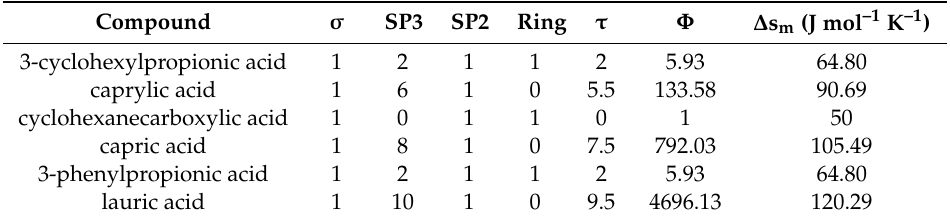
Table 1. Symmetry number σ , flexibility number Φ , and calculated melting entropy ∆ s m of components using the model proposed by Jain et al.